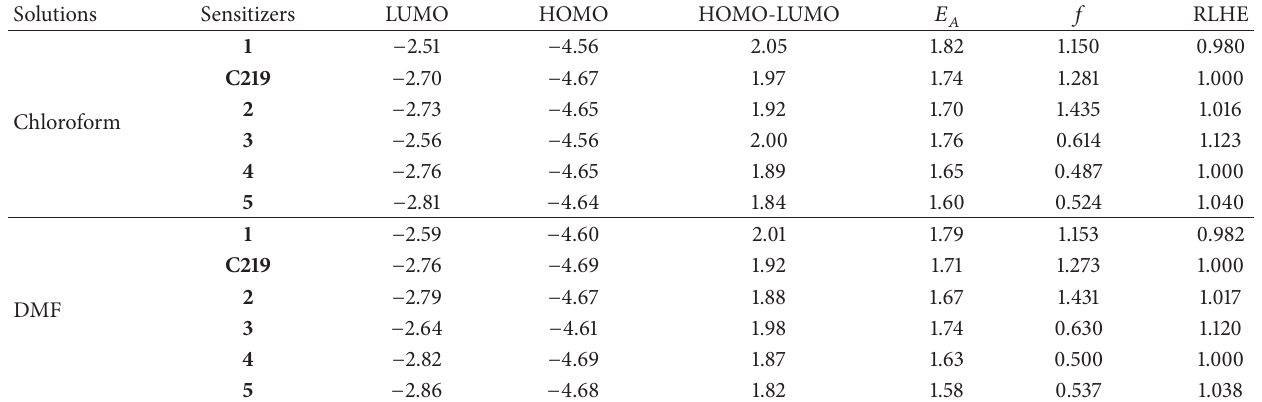
Table 2: The HOMO and LUMO energies, HOMO-LUMO gaps, lowest vertical excitation energies ( 𝐸 𝐴 ), oscillator strengths ( 𝑓 ), and relative LHE (RLHE) for all sensitizers a .